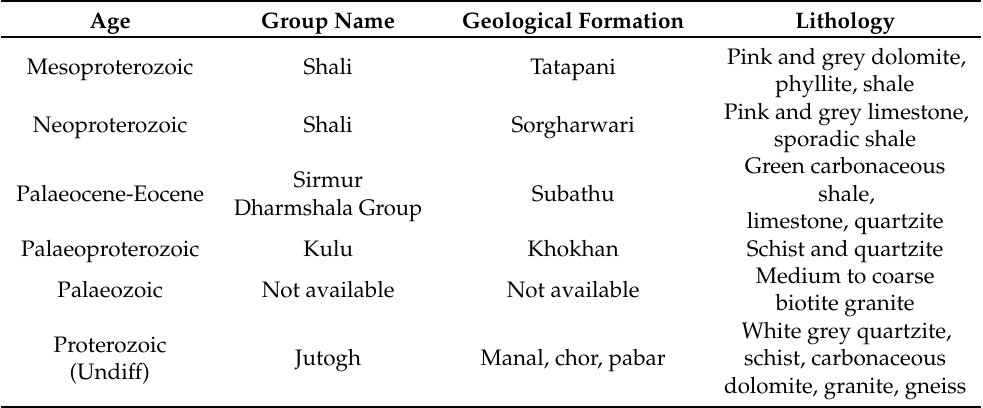
Table 1. Lithology of the study